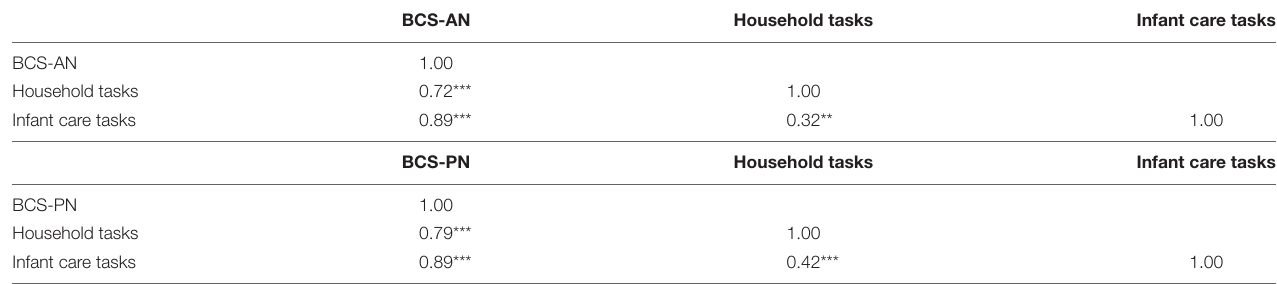
TABLE 4 | BCS-AN and BCS-PN intercorrelations. BCS-AN Household tasks Infant care tasks